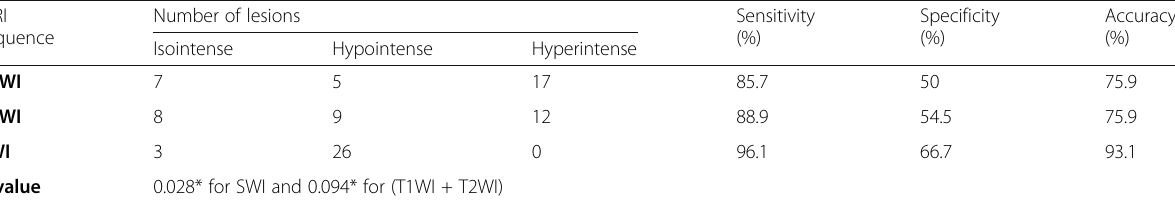
Specificity Accuracy (%) (%) (%)